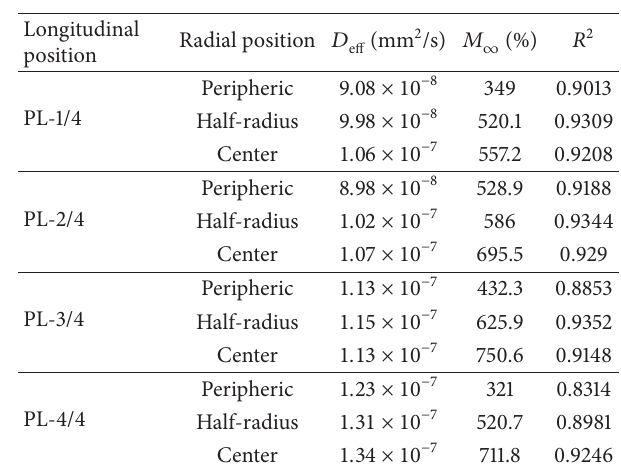
Table 5: Effective diffusion coefficients and some parameters of Raffia vinifera fibers obtained by the method of Fickian diffusion along the stem.